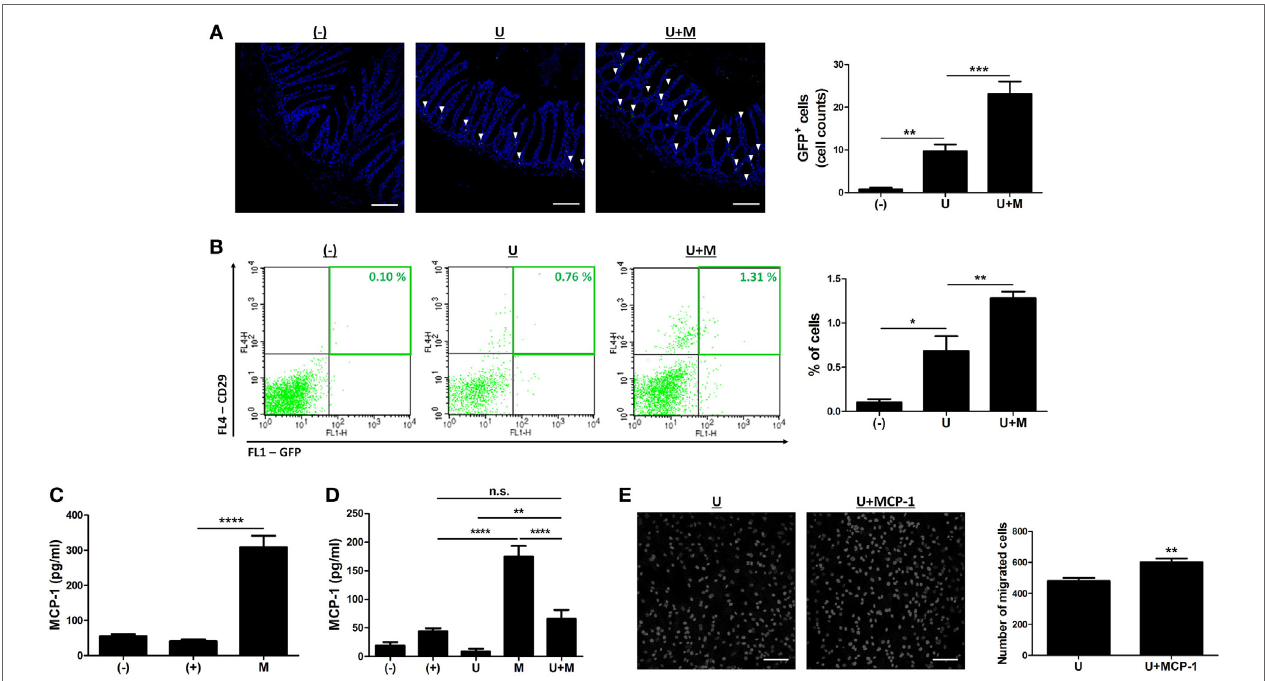
FigUre 7 | MIS416 increases the systemic level of MCP-1 which promotes migration of human adult stem cells, including umbilical cord blood-derived mesenchymal stem cells (hUCB-MSCs) toward the lesion. (a,B) Green fluorescent protein (GFP) expressing hUCB-MSCs were injected intraperitoneally into dextran sulfate sodium (DSS)-induced colitis mice. The colon sections were examined for green fluorescent cells using a confocal microscope and flow cytometer a day after injection (day 2). (a) Representative images of colons by confocal microscopy, bar = 100 µm, and the quantification. ▾ ; eGFP positive cells. (B) Populations of GFP positive hUCB- MSCs were analyzed by flow cytometric analysis. (c,D) Levels of MCP-1 in serum were evaluated by CBA. Each group of mice was sacrificed on (c) day 2 and (D) day 11. (e) hUCB-MSCs were incubated with MIS416 for 24 h. In vitro migration ability of hUCB-MSCs was determined using Transwell migration assay. Representative of confocal microscopy images of migrated hUCB-MSCs, bar = 100 µm, and the quantification. n = 8–11 mice per group, three independent animal experiments were performed. In vitro experiments were performed in triplicate. ( − ): negative control group, ( + ): DSS administered group, U: hUCB-MSCs treated group, M: MIS416- treated group, U + M: hUCB-MSCs and MIS416 co-treated group. * P < 0.05, ** P < 0.01, *** P < 0.001, **** P < 0.0001. Results are shown as the mean ±